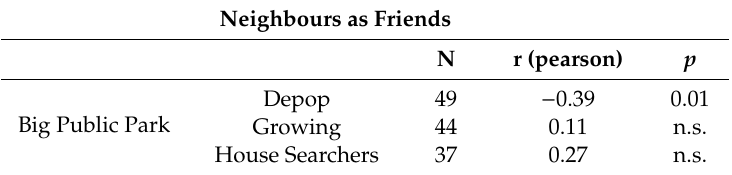
Table 3. Significance and correlation coe ffi cients rs between the levels “big public park” and “neighbours as friends”, according to the subgroups: “depopulating neighbourhoods”, “growing neighbourhoods”, and “house searchers”.